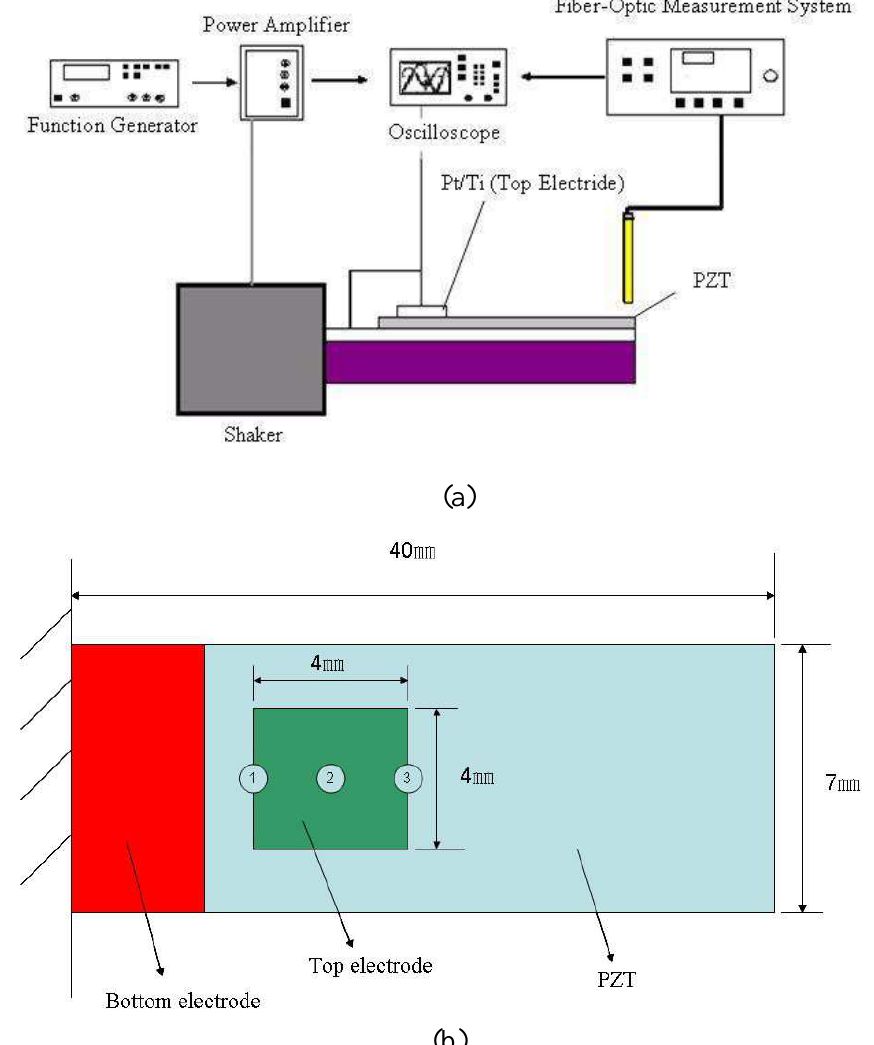
Figure 6. (a) Schematic diagram of experimental setup for tests of PZT films and (b) top view of the clamped